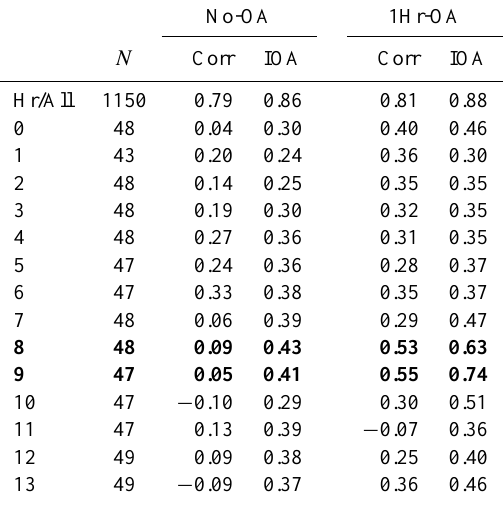
Table 5. Statistics of ozone on 25 September 2013, all day and hours 0 to 13. Both correlation and index of agreement are unit- less. The bold numbers indicate the 3h (07:00 to 09:00CST) when the ozone in 1Hr-OA case is significantly better than the No-OA case due to much improved